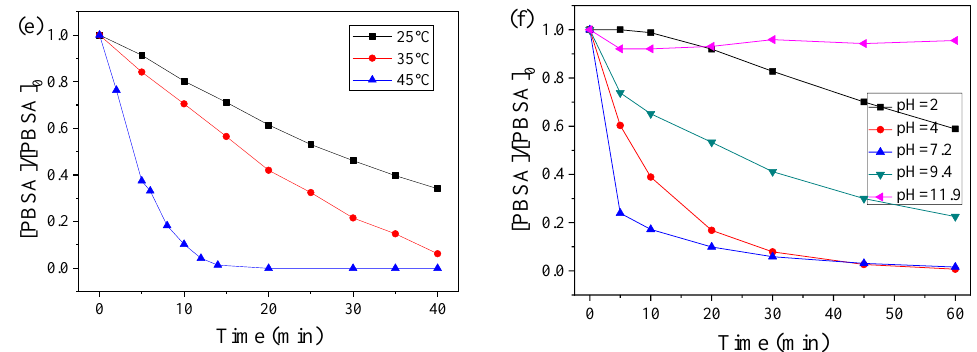
Figure 4. Influences of the different catalysts ( a ), CoMn 2 O 4 dose ( c ), PMS dose ( d ), reaction temperature ( e ), and pH on the PBSA removal ( f ) and BP-4 and phenol removal ( b ) by the CoMn 2 O 4 /PMS system. Conditions: [PBSA] = 5 mg L −1 ; [BP-4] = [phenol] = 18.23 mM; [catalyst] = 50 mg L −1 (10 mg L −1 , Figure e ); [PMS] = 250 mg L −1 ; T = 25 °C; and without pH adjustment.